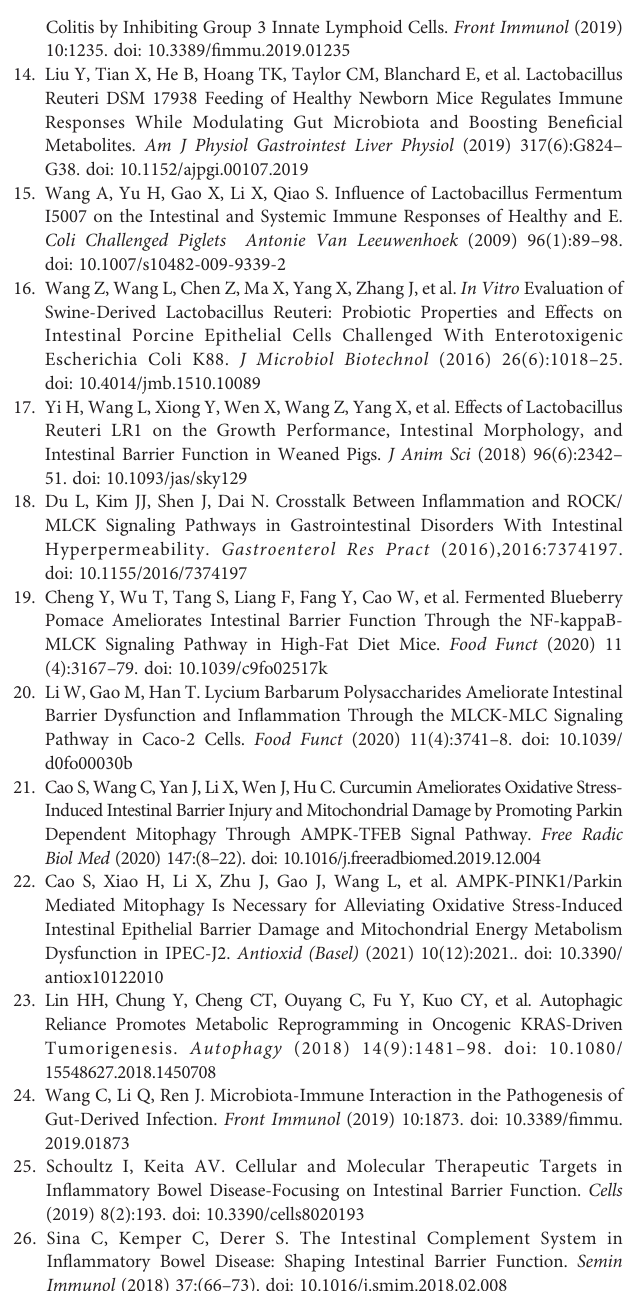
Supplementary Figure S2 | IL-17A protein expression. (A) IL-17A proteins expression in mouse colon and IPEC-J2 cells. Supplementary Figure S3 | Knockdown MLCK inhibition the effects of L. reuteri LR1 on the in fl ammatory response in IPEC-J2 Cells treated with ETEC K88. (A) Gene expression of IL-8 determined by qPCR in IPEC-J2 cells transfected with negative control siRNA or siRNA targeting MLCK. (B) Gene expression of TNF- a determined by qPCR in IPEC-J2 cells transfected with negative control siRNA or siRNA targeting MLCK. Data presented as mean ± SEM (n=3). ***p < 0.001 vs. Control group, ##p < 0.01 and ###p < 0.001 vs. ETEC K88 group, &p < 0.05 and &&p < 0.01 vs. siNC+LR1+ETEC K88